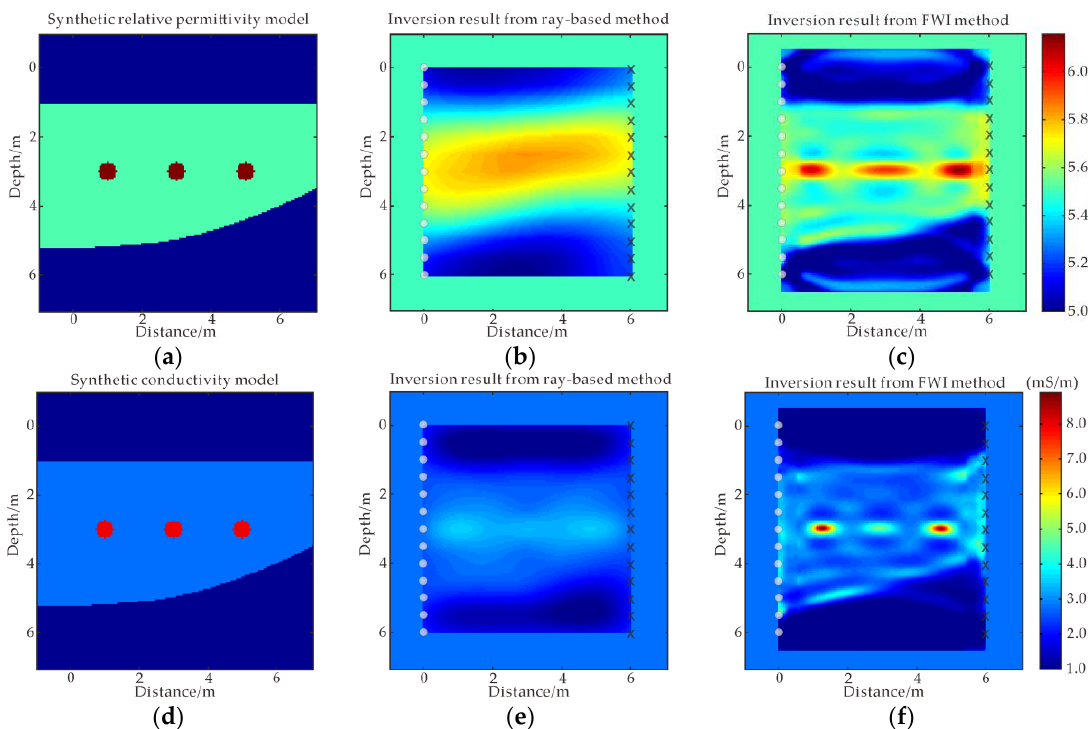
Figure 4. A complex synthetic model with three pipeline anomalies buried in the layered medium. Model parameters of ( a ) relative permittivity and ( d ) conductivity; ray-based results of ( b ) relative permittivity and ( e ) conductivity; FWI results of ( c ) relative permittivity and ( f ) conductivity.